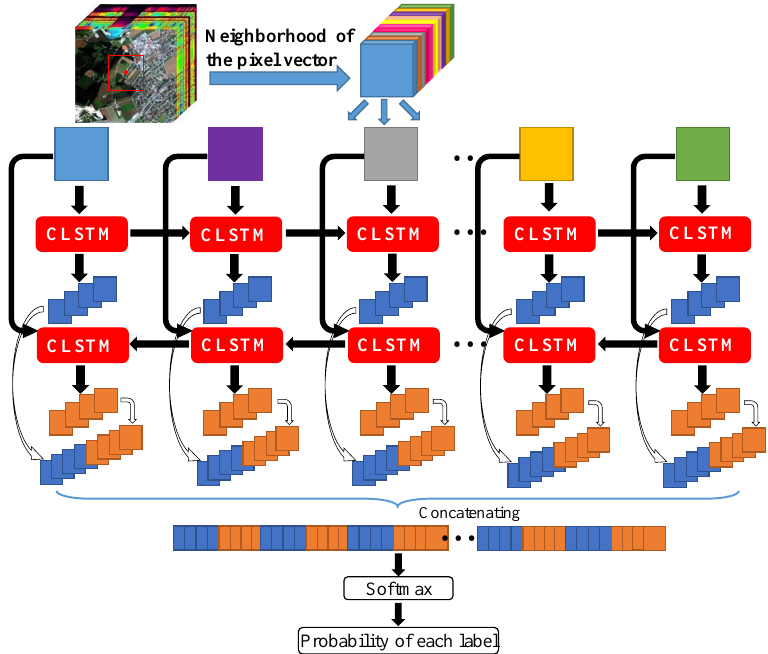
Figure 2. Flowchart of the Bi-CLSTM network for HSI classification. For a given pixel, a local cube surrounding it is first extracted, and then unfolded across the spectral domain. The unfolded images are fed into the Bi-CLSTM network one by